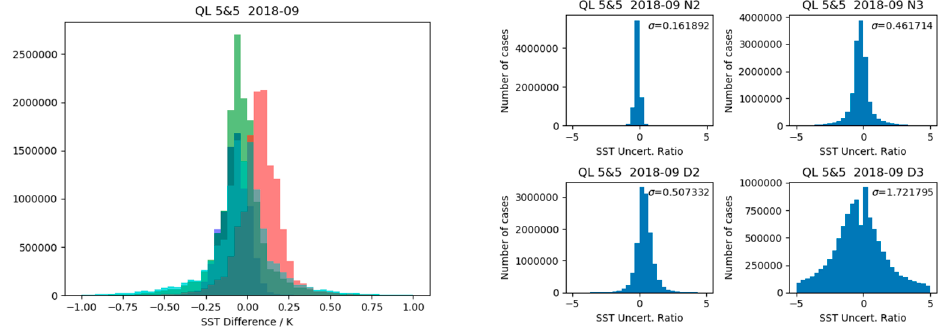
Figure 9. Left : Histogram of A-B SST differences, per retrieval algorithm (N2-blue, N3-green, D2-red, D3-cyan). Right : normalized differences for each retrieval algorithm. All data are for quality level 5. The raw histogram reveals that, in general, the two instruments provide very similar SSTs. The histograms of normalized differences reveal an over-estimation of the N2 retrieval uncertainty, a fair estimation for the N3 and D2 retrievals, and an under-estimation for the D3 algorithm. Reprinted from [25].